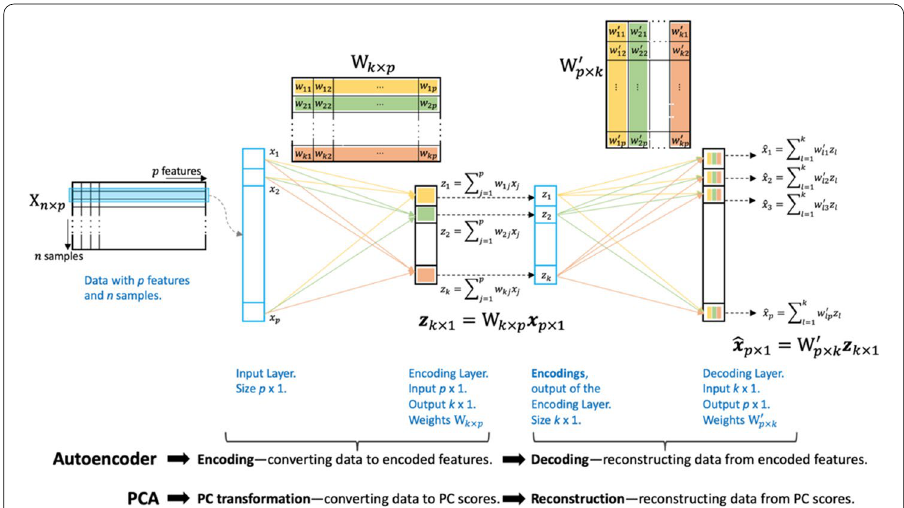
Fig. 1 Single layer autoencoder vs PCA